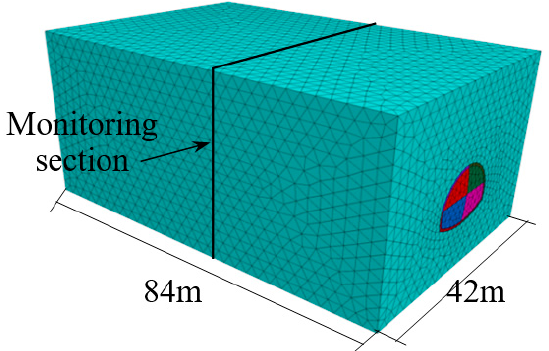
Figure 8. Schematic diagram of tunnel model and monitoring section.